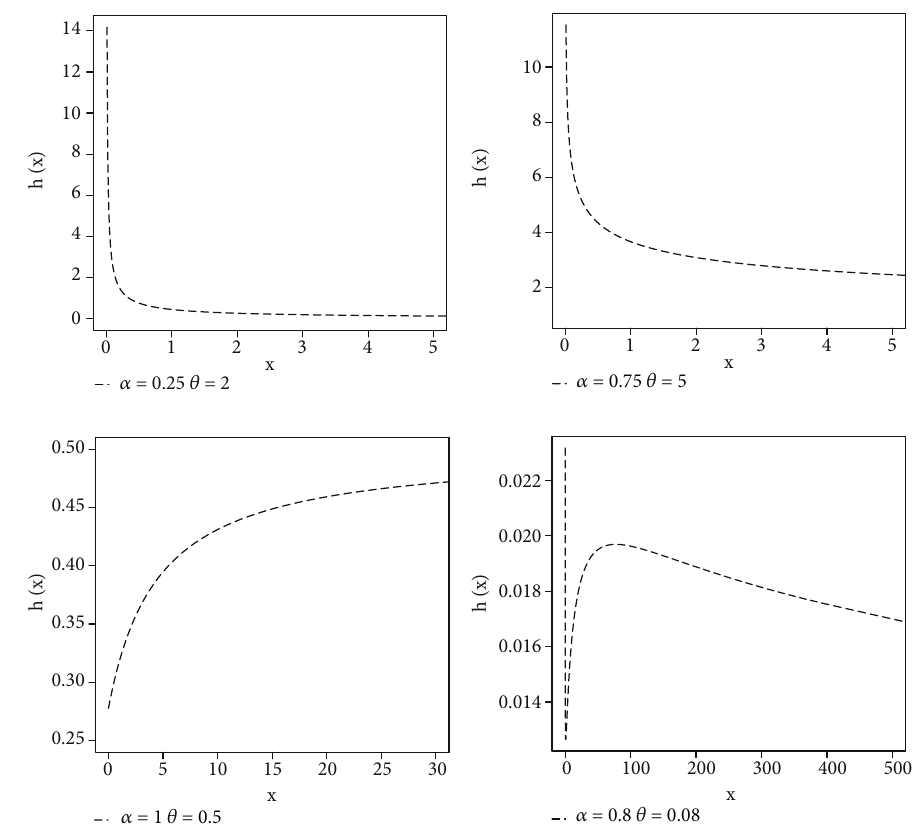
Figure 2: Plots of HRF of PXL distribution for some parameter values. Table 1: Traditional and fuzzy reliability with di ff erent